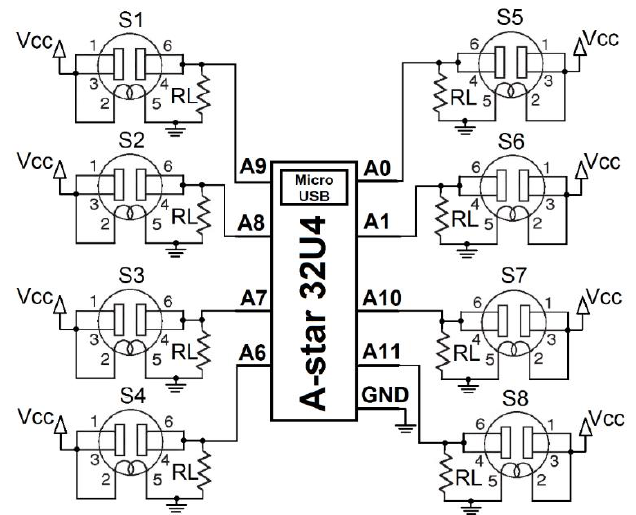
Figure 2. Measurement circuit for gas